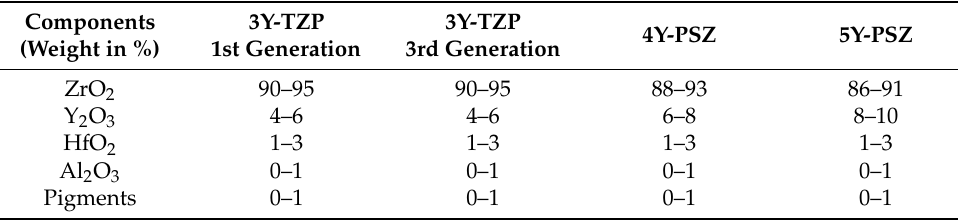
Table 1. Chemical composition of the zirconias that were used in the present study. Components